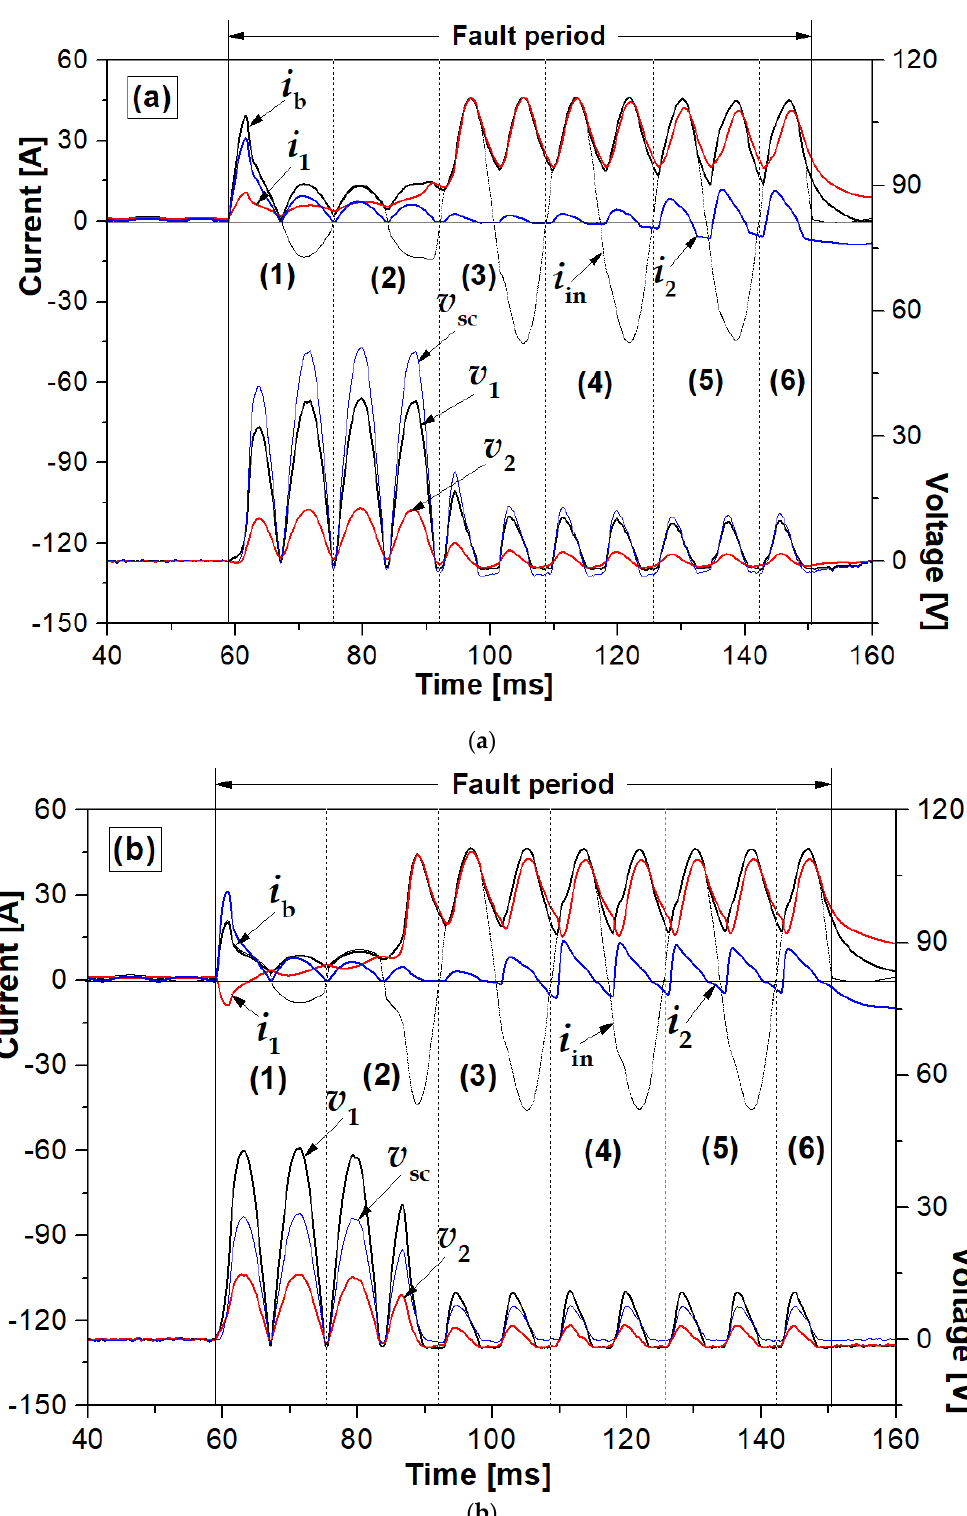
Figure 4. Fault current limiting characteristics and voltage waveforms of bridge type SFCL with a single HTSC element using flux-coupling according to the connection direction between N 1 and N 2 . ( a ) In the case of the subtractive polarity winding. ( b ) In the case of the additive polarity winding.